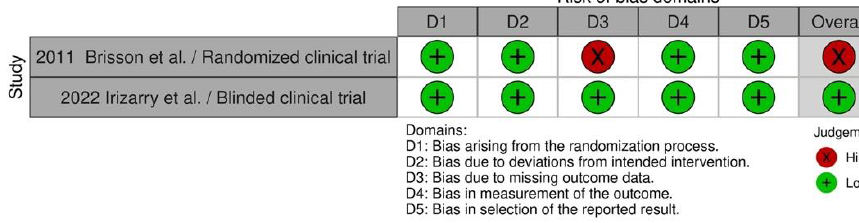
Figure 3. Summary plot of cohort studies.